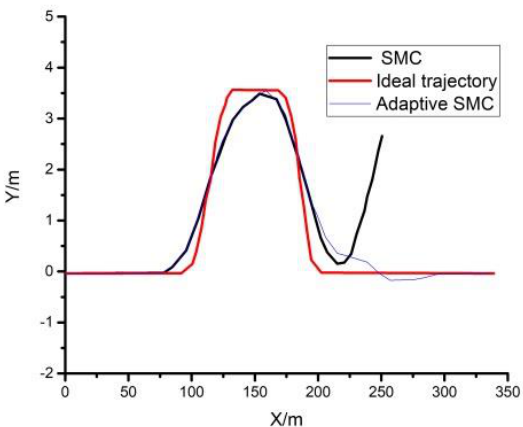
Figure 19. Vehicle centroid trajectory.